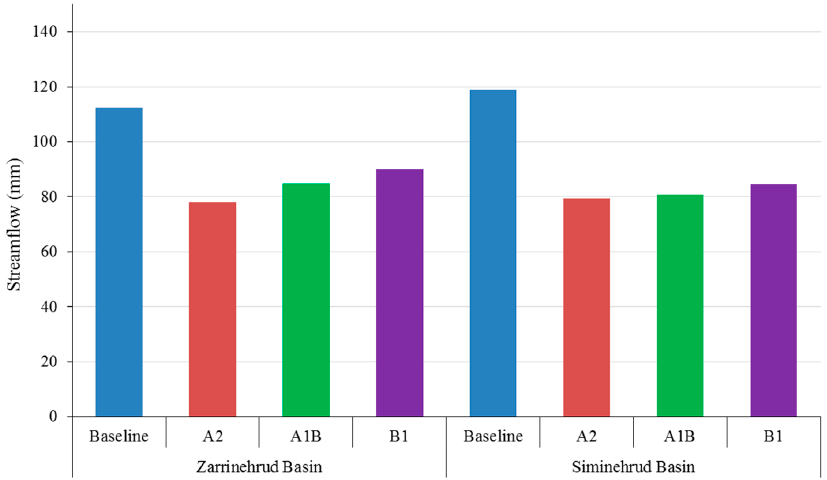
Figure 7. Comparison of mean streamflow in the future period (2015–2040) under different emission scenarios as compared to the baseline period (1986–2010).